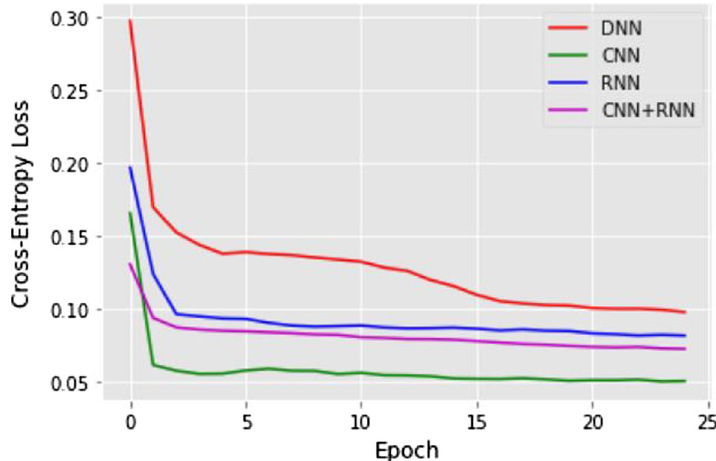
Fig. 11 Plot of loss vs. epoch